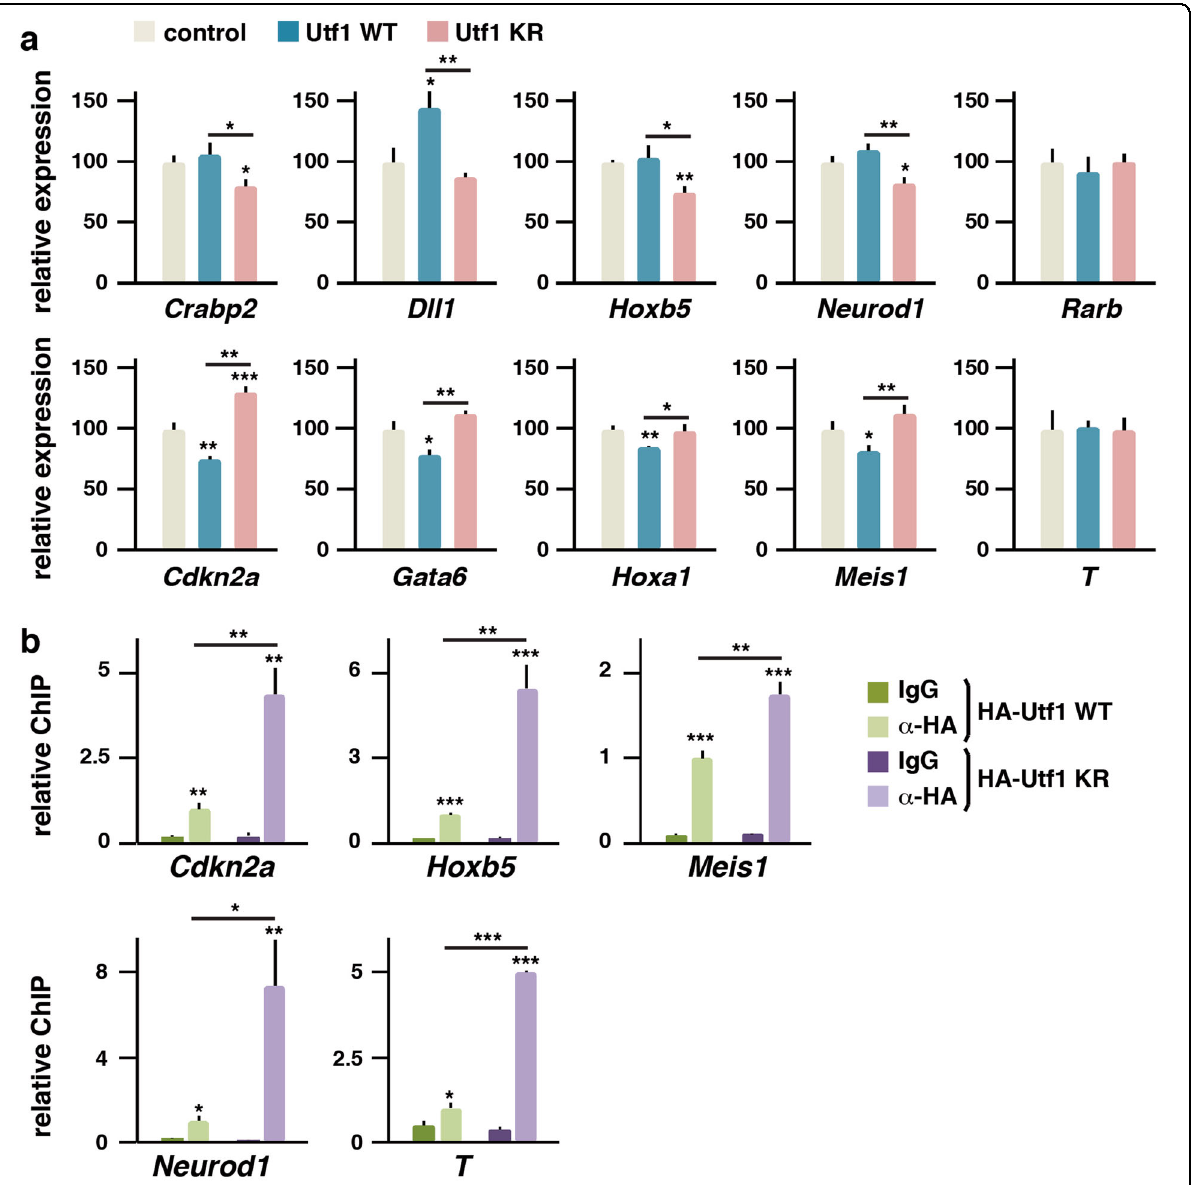
Fig. 5 Sumoylation of Utf1 modulates chromatin af fi nity. a Expression of the indicated bivalent genes was assessed in P19 cells by quantitative PCR after 48 h of RA treatment in the absence (control, empty vector) or the presence of expressed WT or KR mutant versions of Utf1. b Localization of expressed HA-tagged WT or KR Utf1 to the indicated promoters was assessed by chromatin immunoprecipitation. IgG controls were established for each expressed construction. Statistical signi fi cance in relation to the control ( a ) or in relation to the corresponding IgG determination ( b ) is indicated on top of each bar, other comparisons are indicated with a line. Statistical signi fi cance was determined by the Student ’ s t test. * p < 0.05, ** p < 0.01, and *** p <